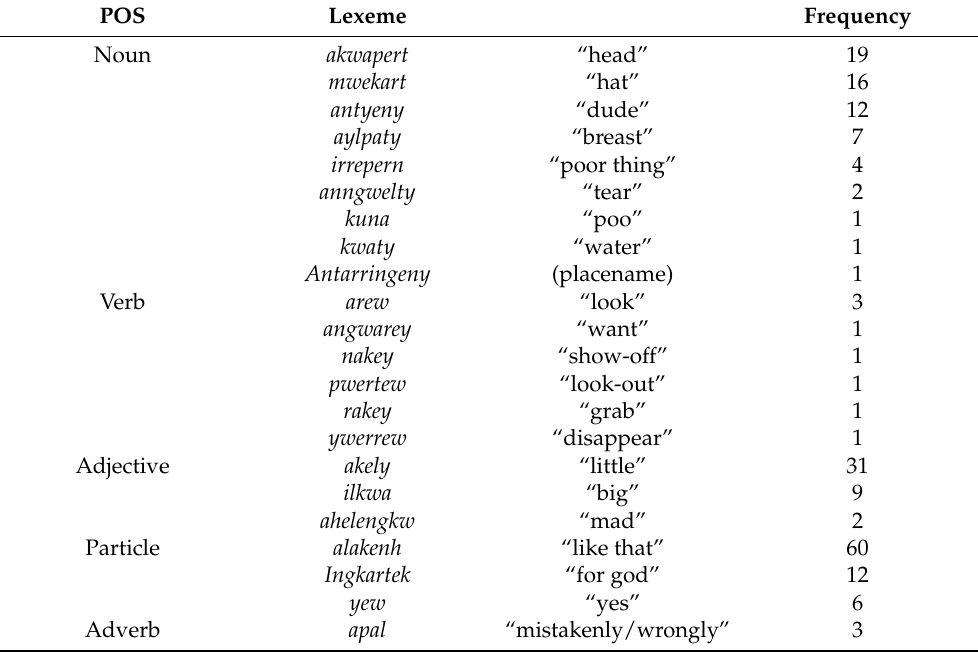
Table A1. Alyawarr-derived lexemes in the play session.